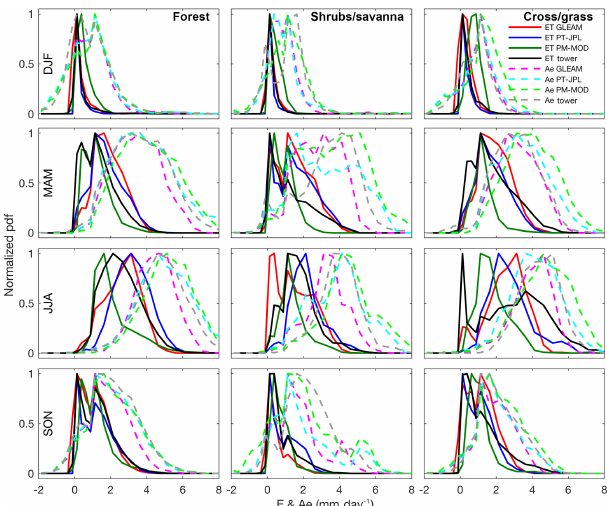
Figure 3. Normalized histograms of ET and available energy (Ae) from GLEAM, PT-JPL, PM-MOD, and the tower observations. The histograms are calculated with the ET values at the tower locations separated first by season and land